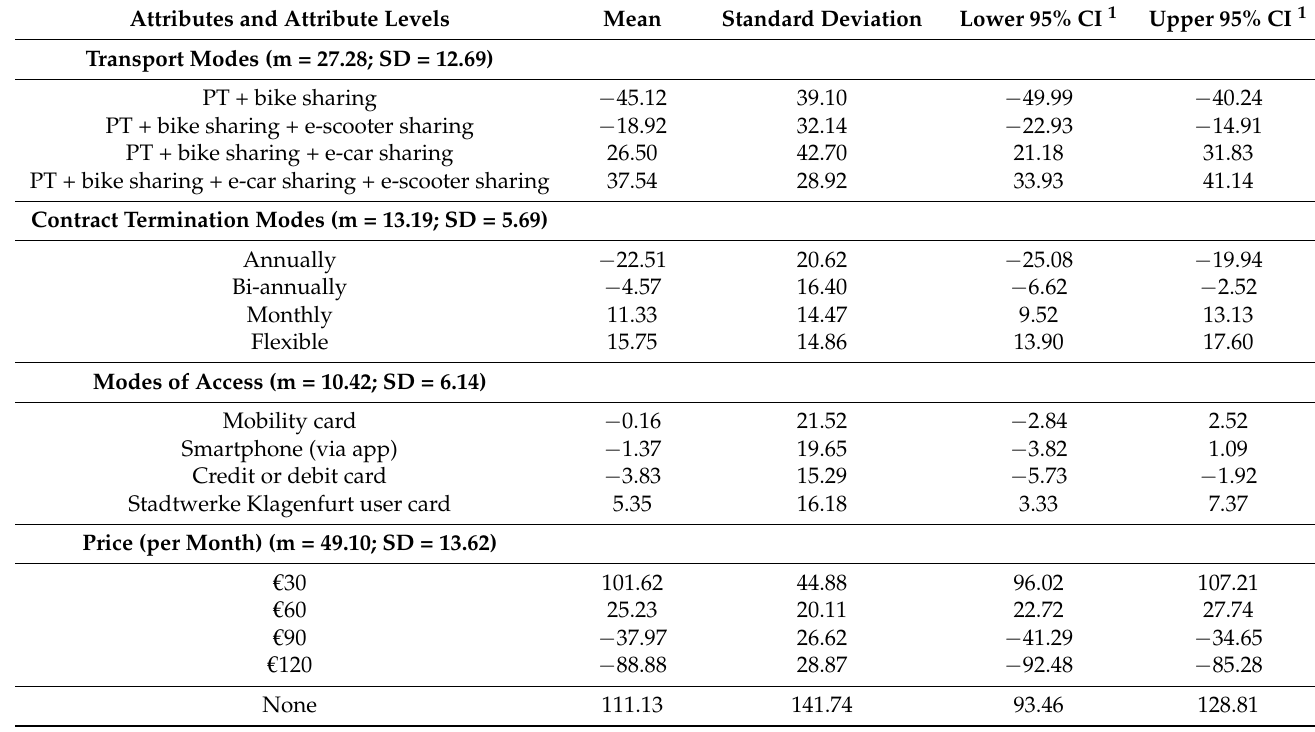
Table 3. The hierarchical Bayes (HB) model estimation of mean utility values and mean relative importance scores ( n = 247). Attributes and Attribute Levels Mean Standard Deviation Lower 95% CI 1 Upper 95% CI 1 Transport Modes (m = 27.28; SD =